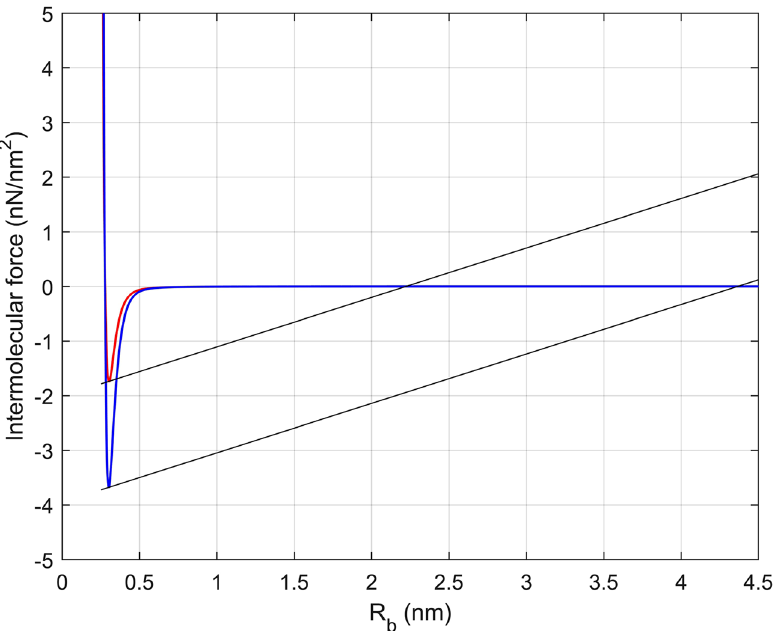
Figure 6. Intermolecular forces-distance graph. Two intermolecular forces (per unit area) at hydrogen bonding density: 2.5 nm −2 (red) and 5 nm −2